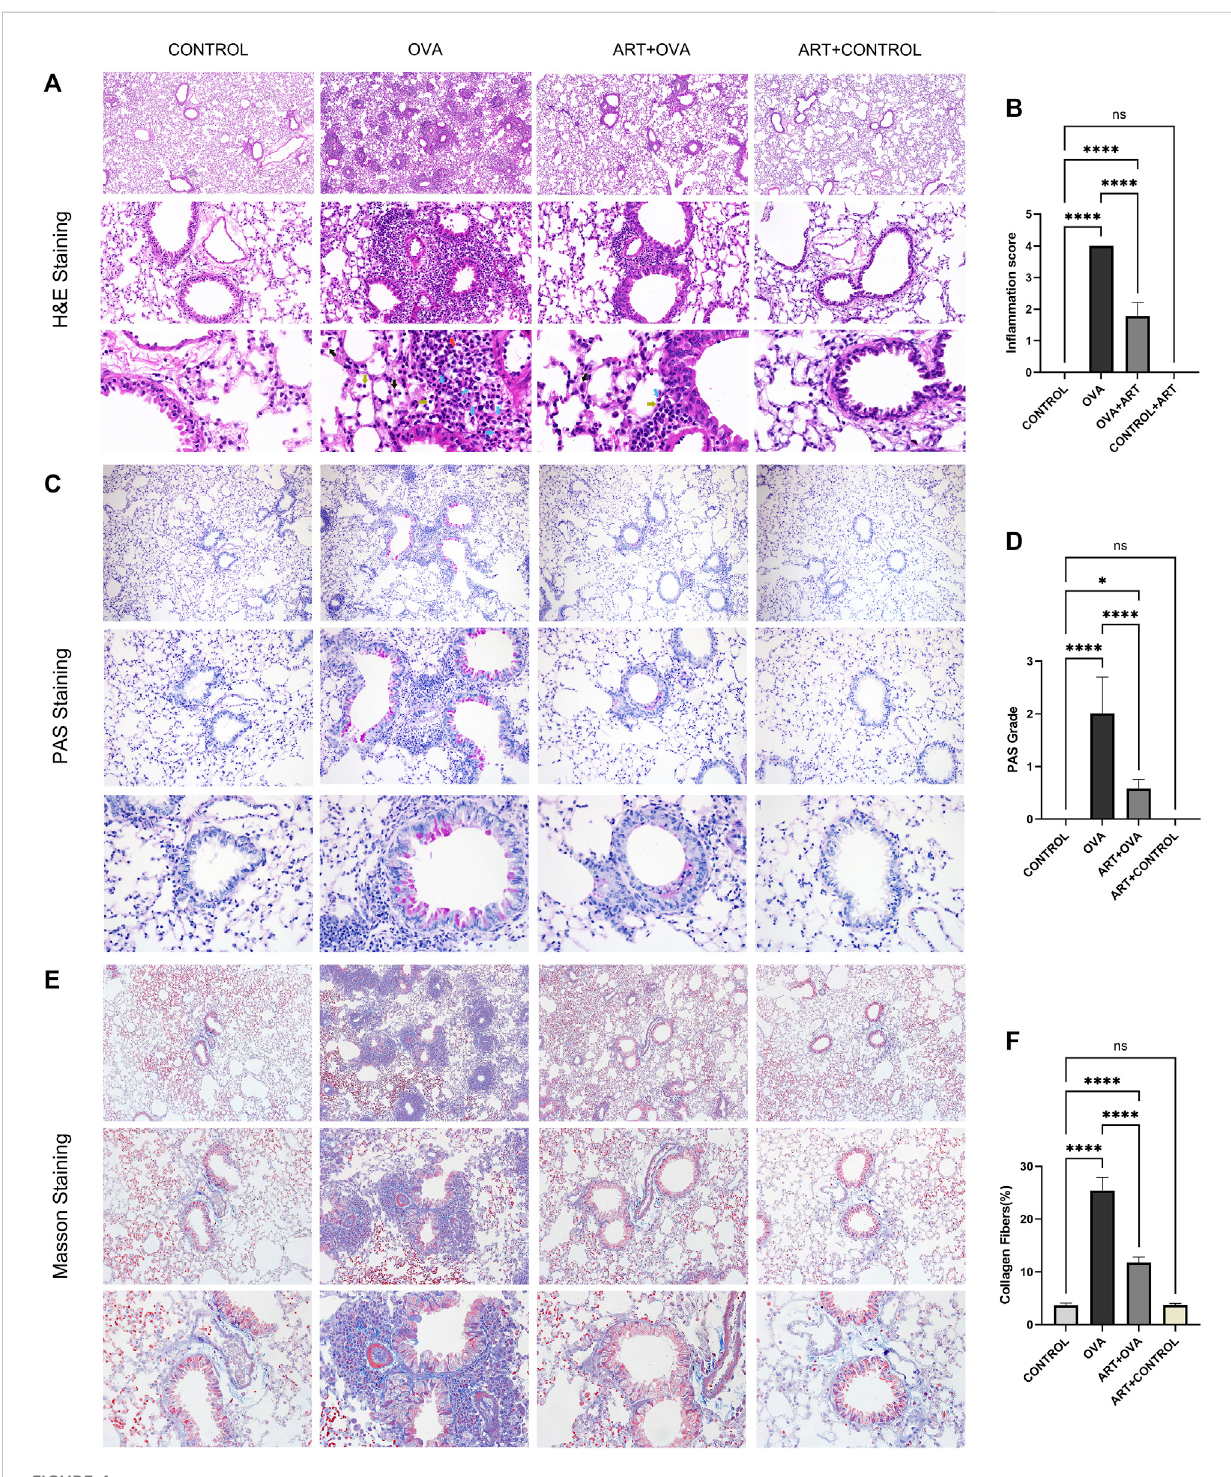
FIGURE 4 Effects of ART treating OVA-induced asthma in mice. (A) , Representative Images of HE (Images were captured at ×100, ×400, and ×1000 magni fi cation). Blue arrows, yellow arrows, black arrows and red arrows refer to eosinophils, lymphocytes, macrophages, and neutrophils respectively. (C,E) , PAS and Masson staining from lung sections each group (Images were captured at ×100, ×200, and ×400 magni fi cation). (B,D,F) The in fl ammatory in fi ltration, goblet cell hyperplasia and Masson positive area were quanti fi ed by in fl ammation scores, PAS scores and percentage of collagen fi bers ( n = 6). * p < 0.05, ** p < 0.01, *** p < 0.001, **** p <